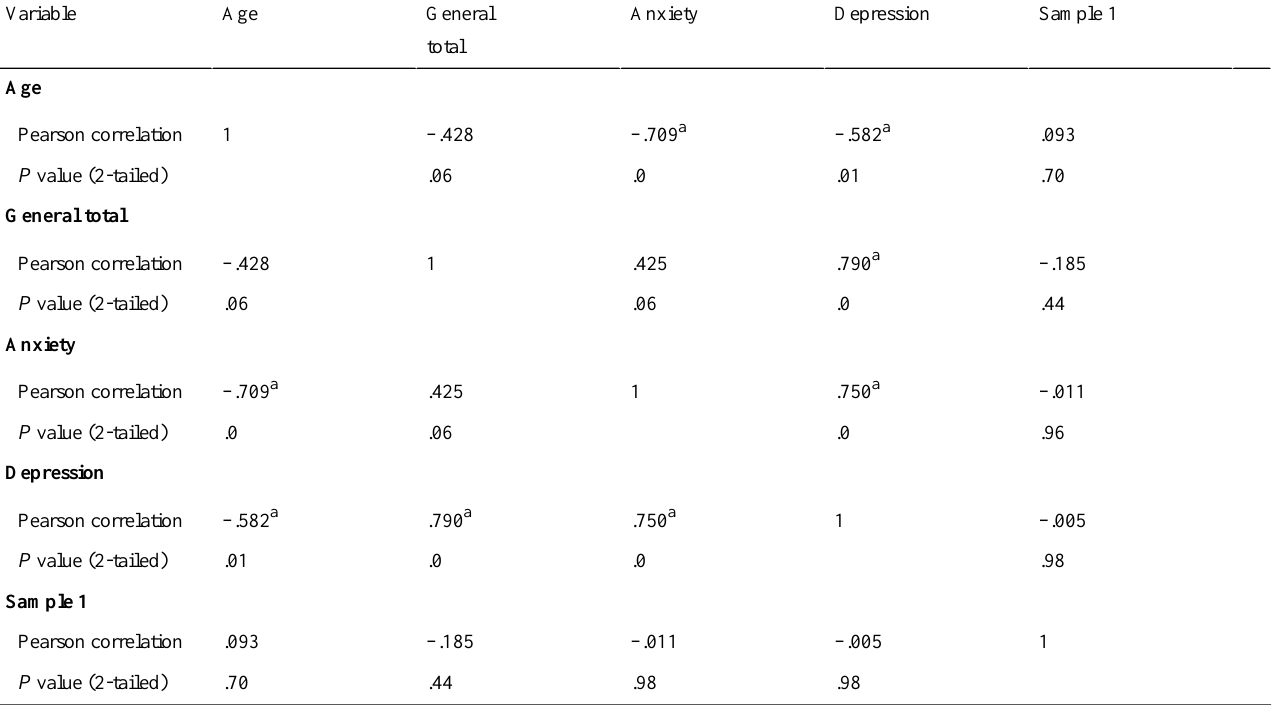
Table 2. Correlations between independent variables (n = 20) for sample 1.